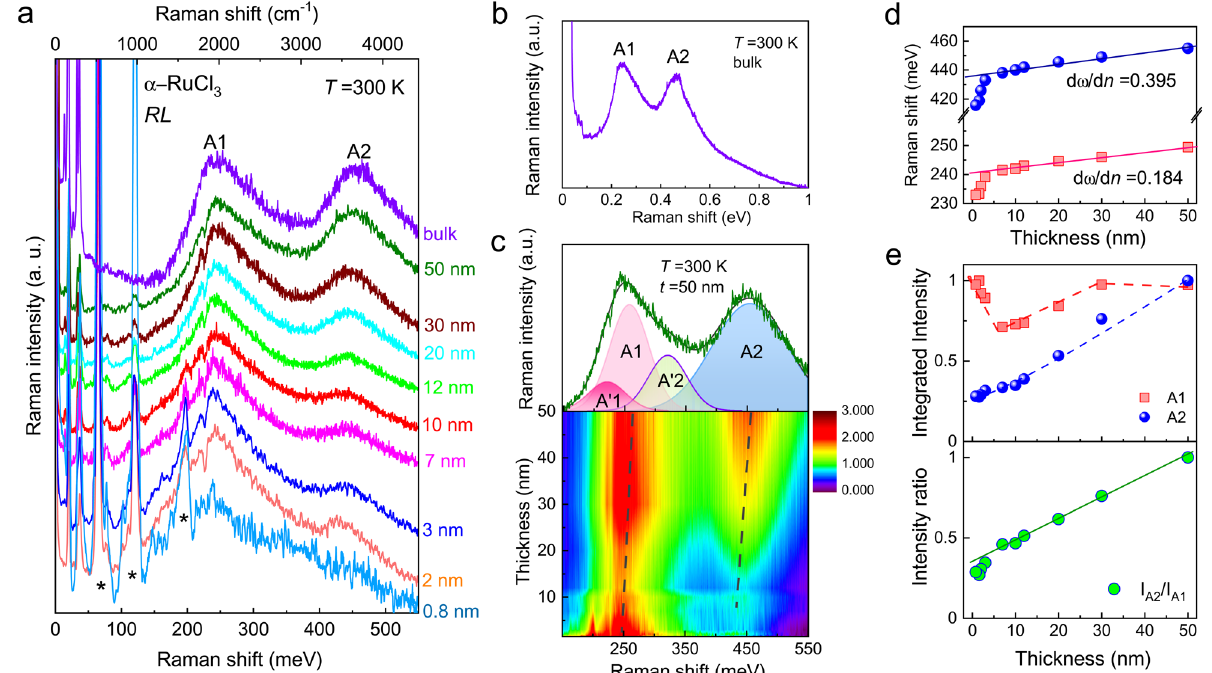
Fig. 3 Multiple spin-orbit excitons and their thickness dependence. a Thickness dependence of spin-orbit exciton excitations measured at T = 300 K in RL polarization. The spectra are vertically shifted for clarity. The asterisks are single-, two, and three-phonon excitations arising from the Si substrate. b Room-temperature Raman spectrum of bulk α -RuCl 3 measured up to Raman shift of 1 eV. c Representative fi t of the spin-orbit excitons to four Gaussian pro fi les A1, A ’ 1, A2, and A ’ 2. False-color map of the Raman intensity in the frequency-thickness plane. d Frequency of the peaks A1 and A2 as a function of thickness. e Thickness dependence of the peak intensities normalized to the value of t = 50 nm as well as of the intensity ratio of the peak A1 to A2. The dashed lines are guides to the